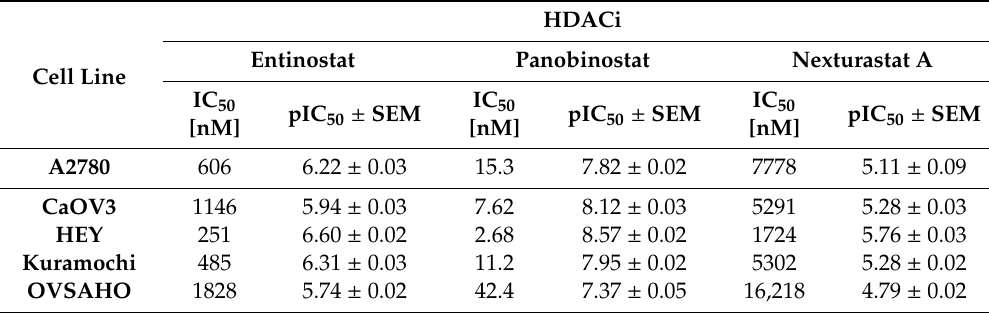
Table 2. Cytotoxic activity of entinostat, panobinostat, and nexturastat A.